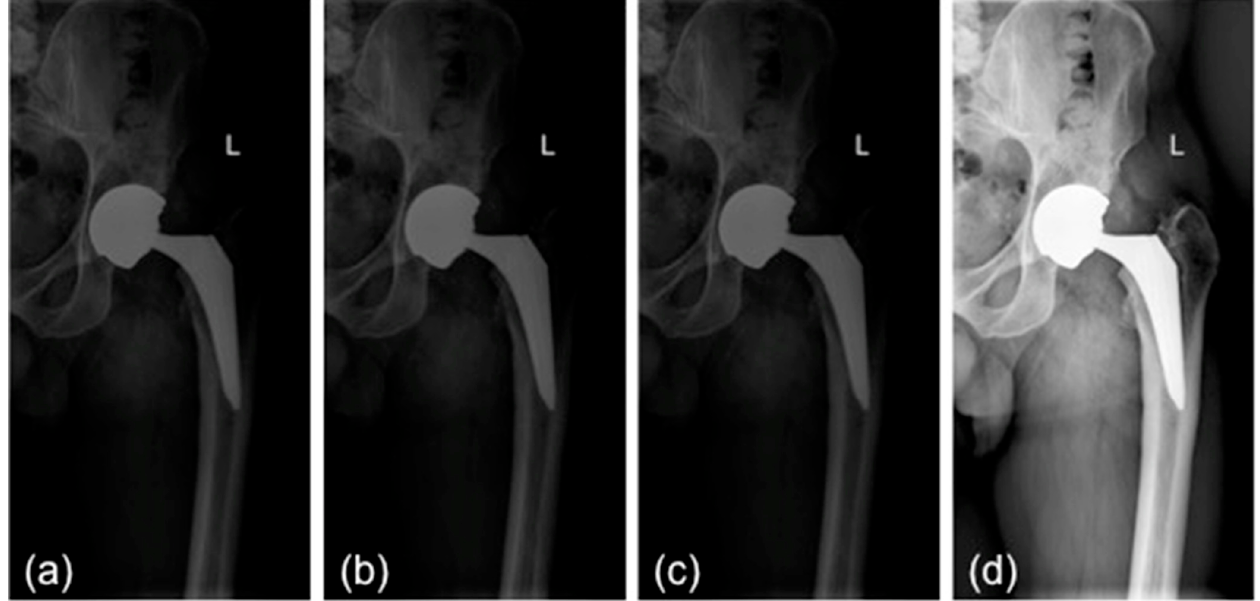
Figure 1. Preprocessing steps: ( a ) initial image; ( b ) mist effect reduction; ( c ) contrast enhancement; ( d ) contrast-limited adaptive histogram equalization. L: left side.